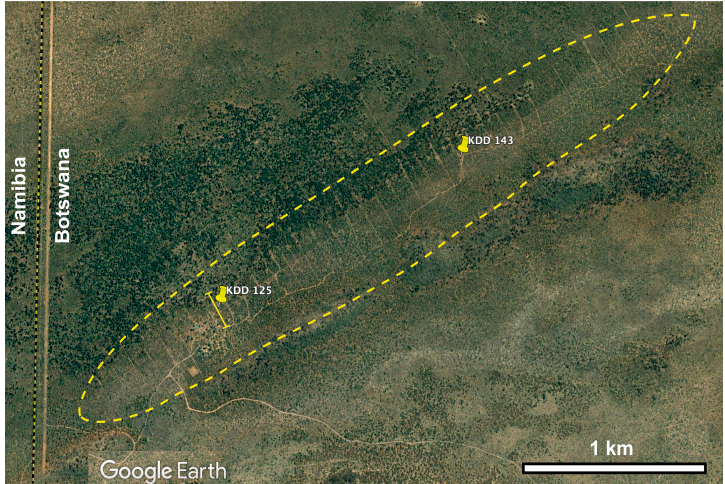
Figure 3. Satellite photograph of the Kihabe prospect (from Google Earth; image 2008), with the position of the analyzed drill holes: KDD 125: 19°42'3.81" S latitude, 21°0'29.78" E longitude; and KDD 143: 19°41'38.37" S latitude, 21°1'15.71" E longitude. The yellow dashed line represents the outline of the mineralization. In correspondence of the drill hole KDD 125, the projection of the geological section depicted in figure 4 is indicated.